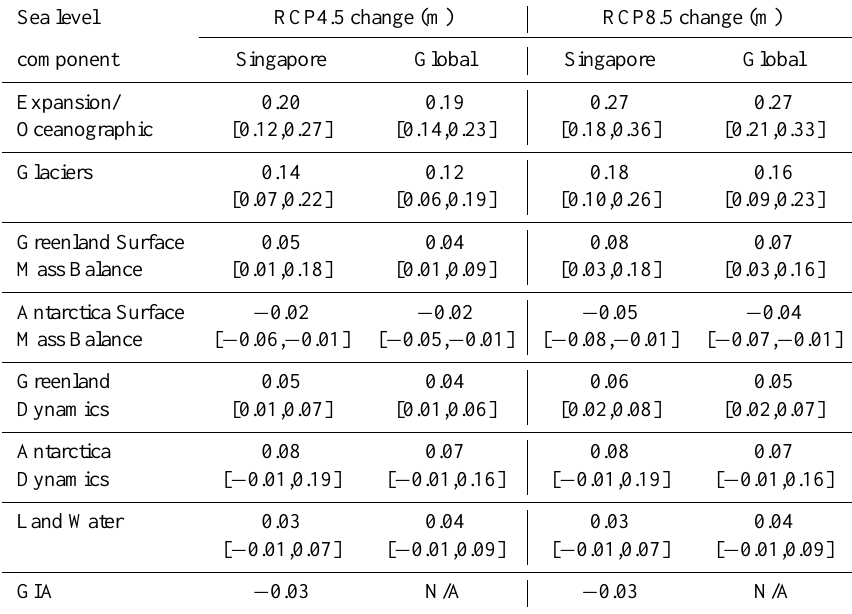
Table 2. Median values and likely (in IPCC calibrated language – see Sect. 2.1) ranges (square brackets) for projections of time-mean sea level rise and its contribution in metres for 2081–2100 relative to 1986–2005 for Singapore and the global average (as reported in Table 13.5 of AR5, Church et al., 2013).